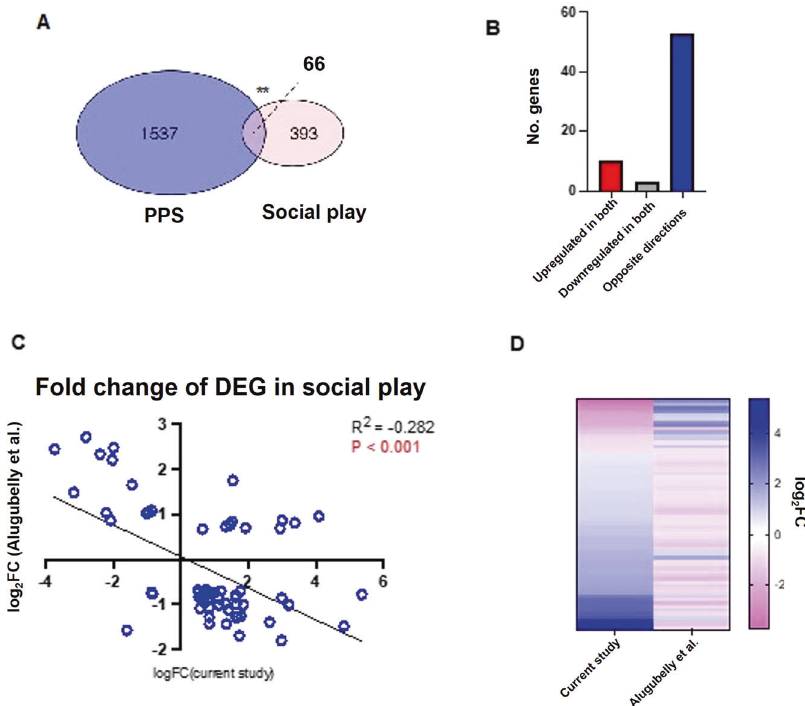
Fig. 5 Overlap of differentially expressed genes with those arising from a social play study. A Venn diagram detailing the signi fi cant overlap between DEGs in the Direct group (CON vs PPS) and an amygdala social play dataset detailed in Alugubelly et al. [55]. B Bar chart showing that most overlapping genes are in opposite directions in both studies. C Fold changes of both datasets are signi fi cantly negatively correlated with one another. D Heatmap showing that expression of overlapping genes are in different directions, suggesting that genes upregulated during social play in the amygdala are downregulated in the PFC of PPS rats during a social interaction. DEGs differentially expressed genes, CON control, PPS prepubertal